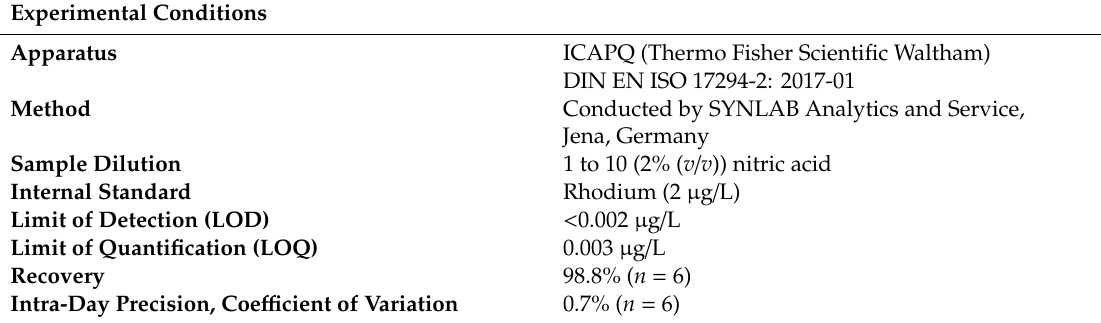
Table 1. Lithium analysis by inductively coupled plasma mass spectrometry